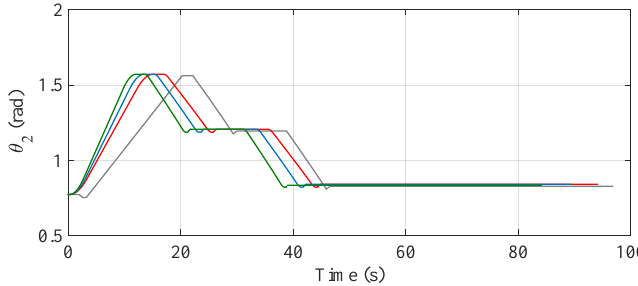
Figure 32. Behavior of the angular position ( θ 2 ) when the path is optimized with α = 0 ( — ), α = 0.5 ( — ) and α = 1 ( — ) and when the optimization is not considered ( — ).